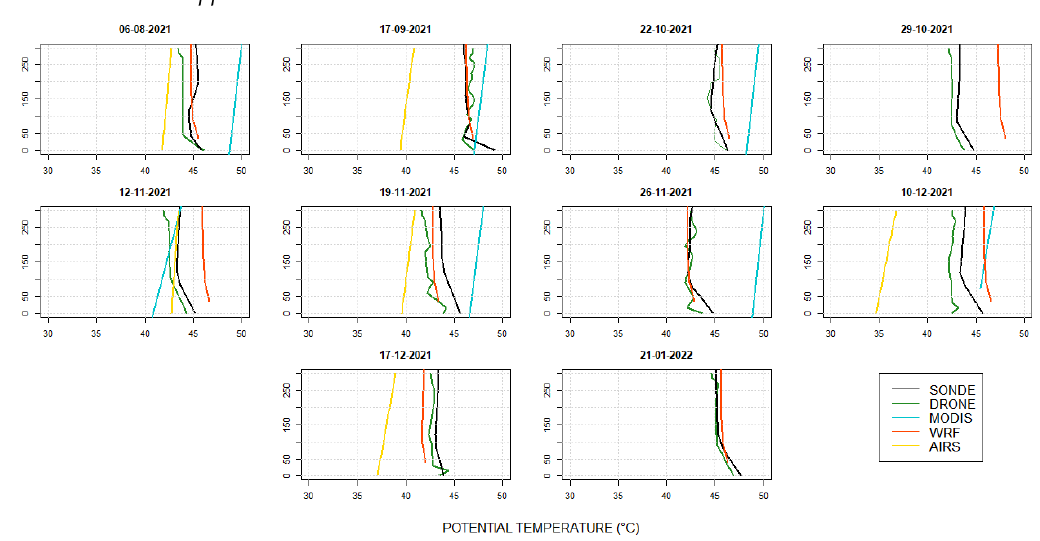
Figure A2. Potential temperature profiles measured with radiosonde (black), drone (green), MODIS (sky-blue), AIRS (yellow), and WRF (orange) up to 300 magl. for 10 measurement events.